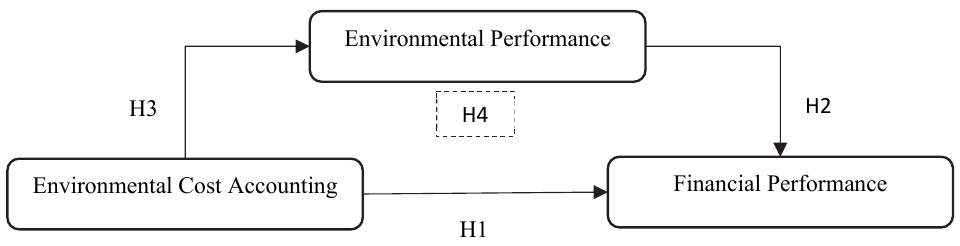
Fig. 1. Proposed Theoretical